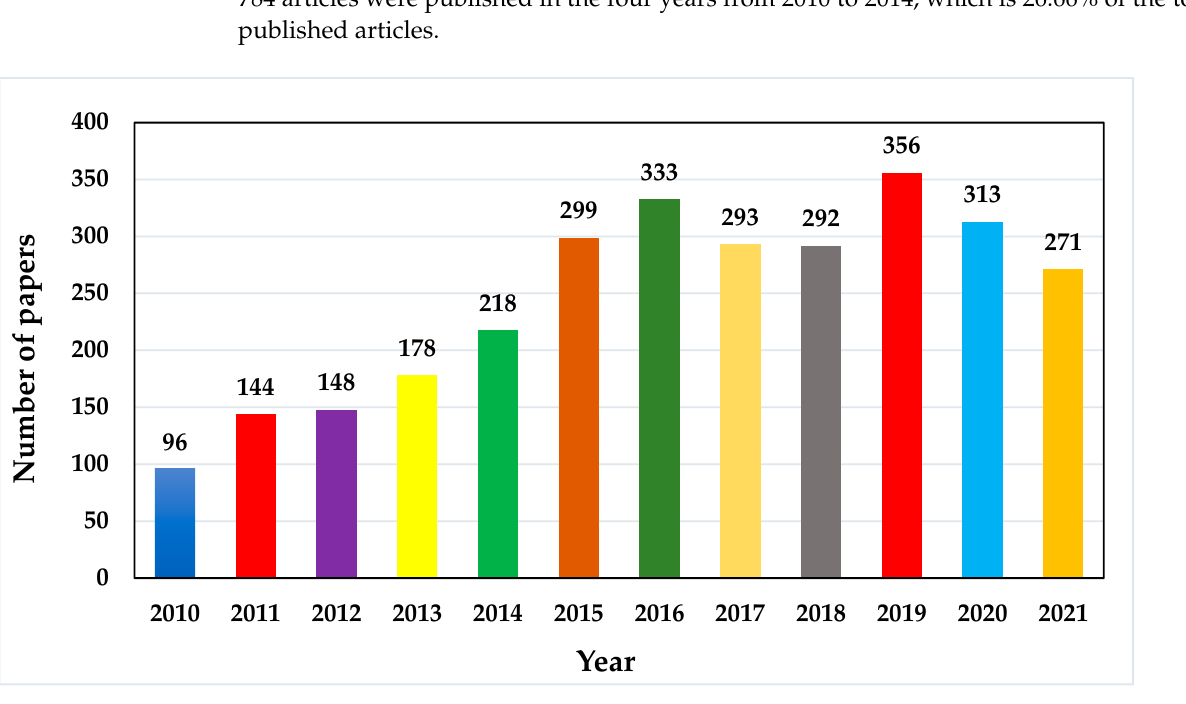
Figure 2. Trends in MESS research from the year 2010 to 2021.